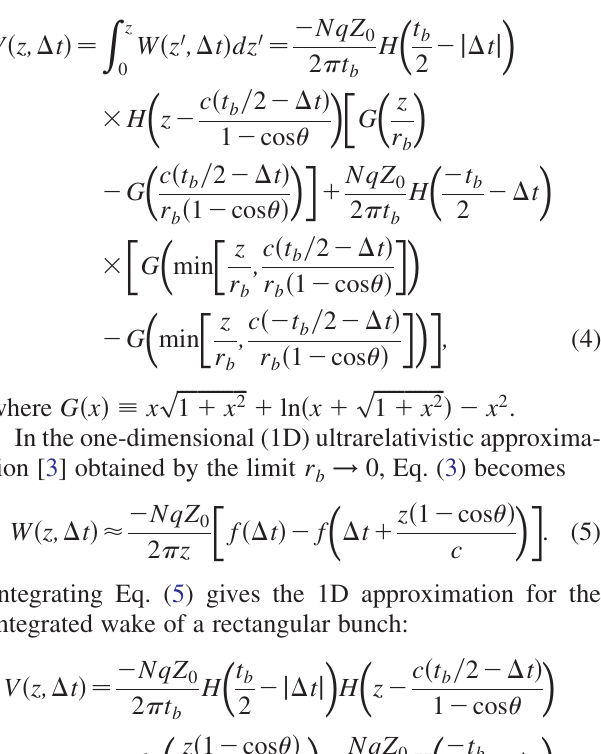
FIG. 3. Longitudinal wakes downstream of a 0.012-rad deflec- tion of a rectangular bunch with charge of 200 pC, duration of 200 fs, and radius of 40 (cid:1) m . Negative wakes correspond to energy loss. Left-hand plots: a dashed red curve shows the entrance-edge wake, a short-dashed green curve shows the exit-edge wake (which is proportional to the bunch current profile). A solid black curve shows the total wake given by their sum. Right-hand plots: integrated total wake. (a) Wakes at a distance of 0.25 m. (b) At a distance of 0.833 m, the entrance- edge wake completely overtakes the bunch. (c) Wakes at a distance of 1.25